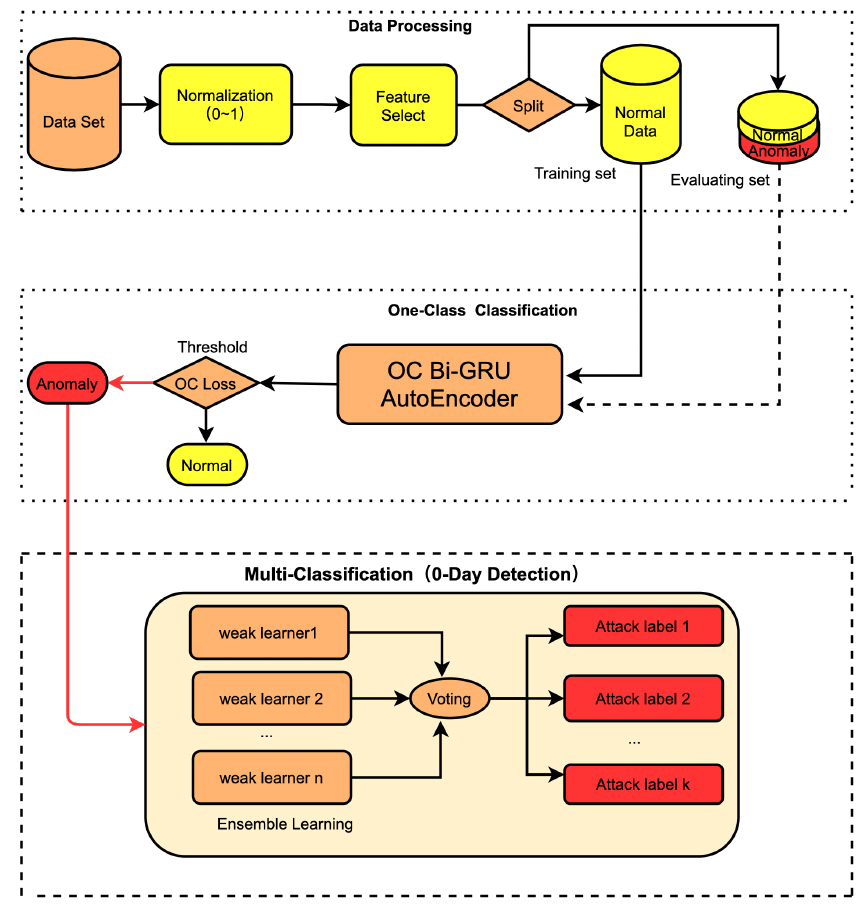
Figure 6. Lightweight intelligent